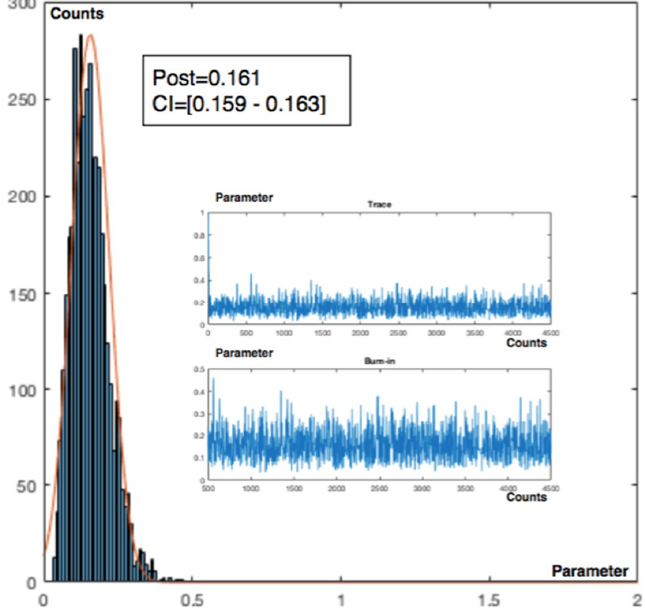
Figure 22. Metropolis–Hastings. Interval 4. Sampling n = 4500, burn = 500; 10 cycles. AR = 56%.